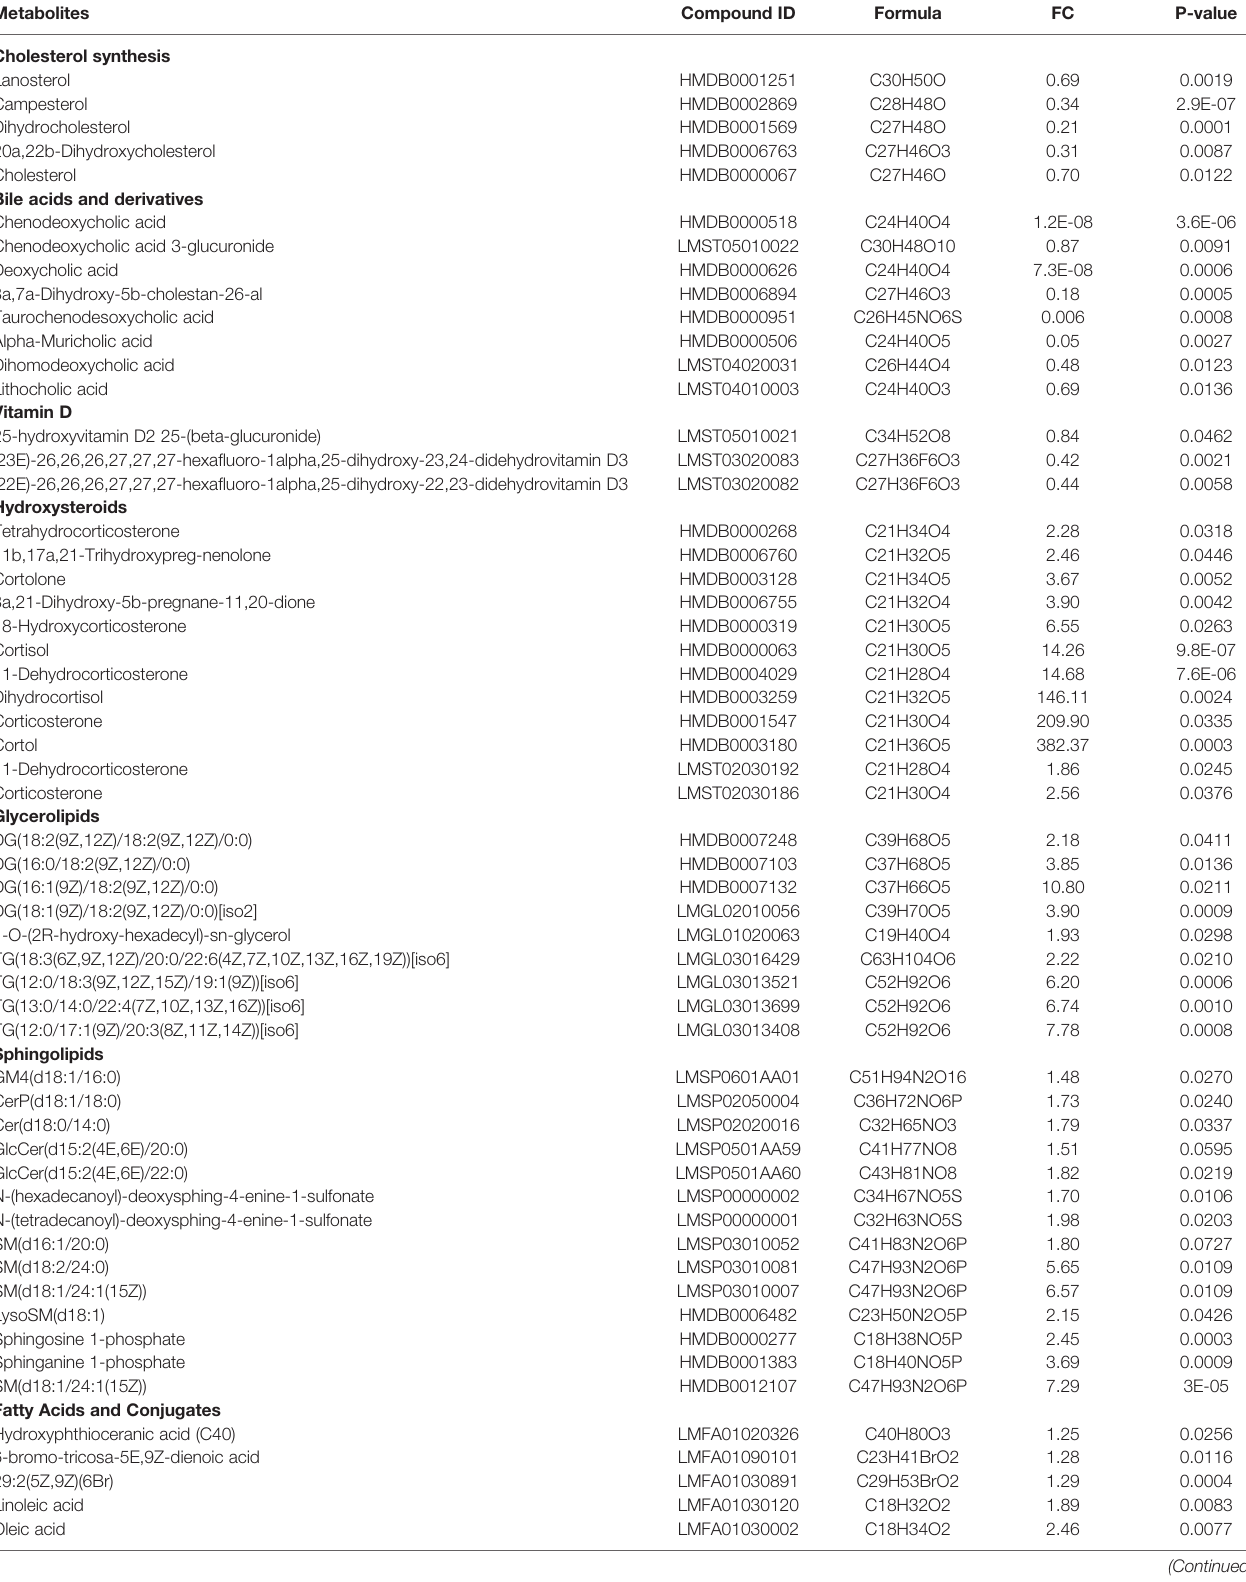
TABLE 3 | The changes of cholesterol and lipotoxicity related